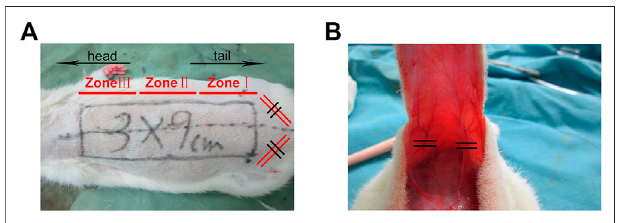
FIGURE 1 | (A) Establishment of modi fi ed McFarlane skin fl ap model. The area with length and width of 9 × 3 cm is divided into Zone I, Zone II, and Zone III from the tail to the head. (B) The fl ap was turned over and the iliac blood vessel was